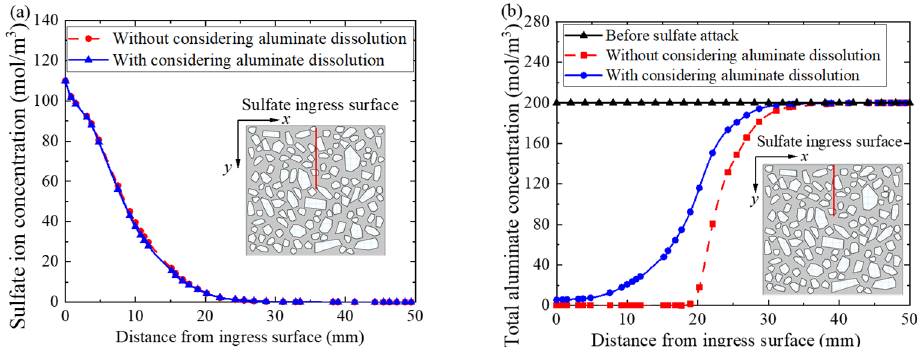
Figure 14. Effect of aluminate reaction and dissolution on sulfate attack. ( a ) Sulfate ion concentration distribution in concrete pore solution on the 360th day of sulfate attack, and ( b ) total aluminate concentration distribution in concrete on the 360th day of sulfate, respectively.